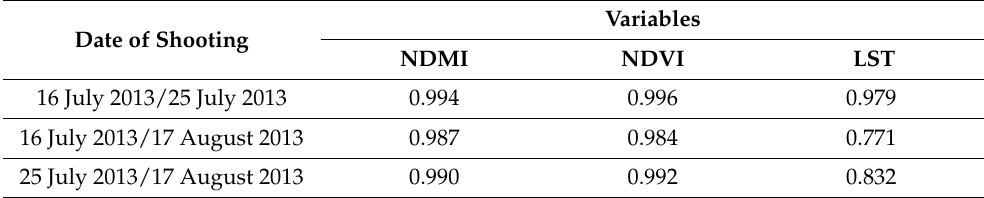
Table 5. Correlation coefficients within parameters between different shooting dates.